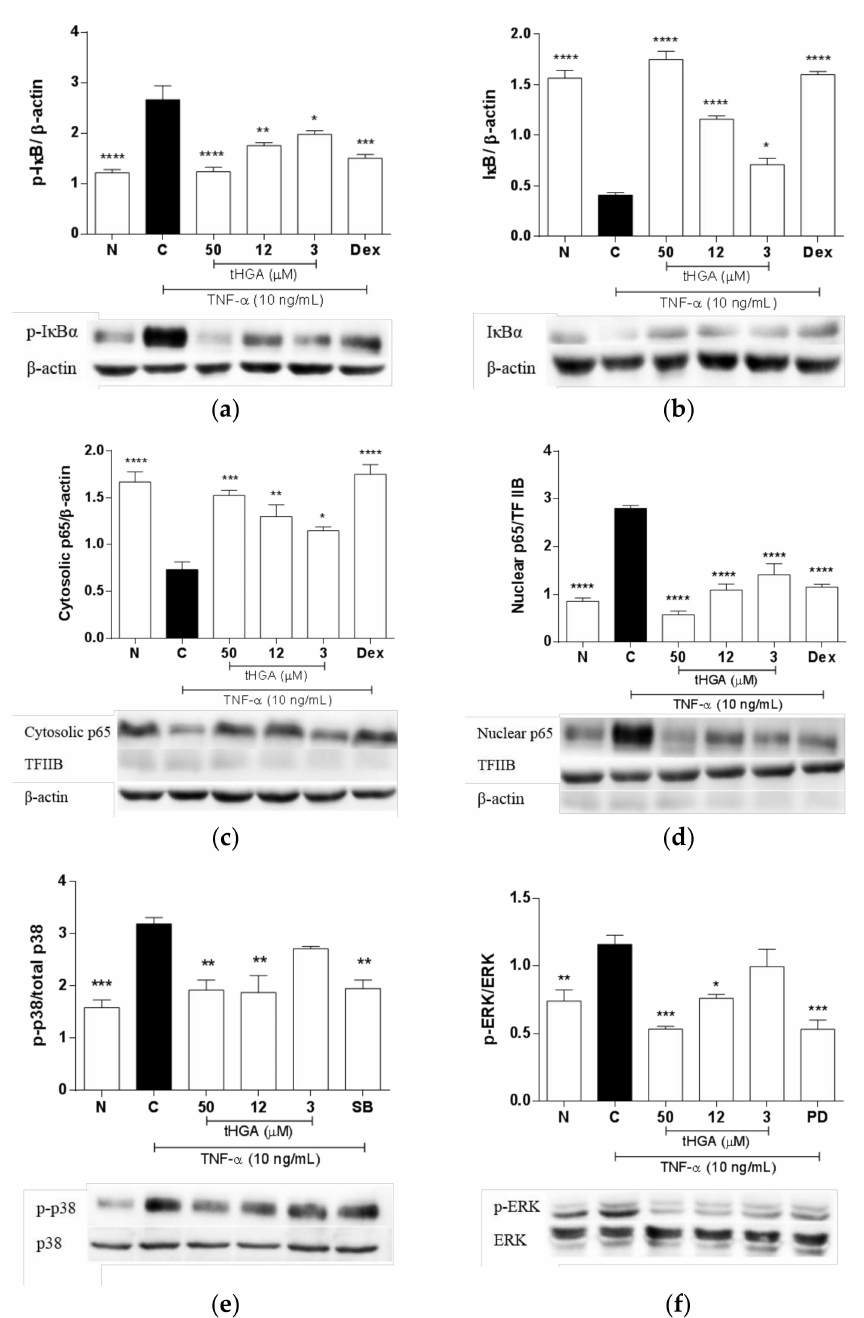
Figure 6. The effects of tHGA on the NF κ B and MAPK signaling pathways in A549 cells following TNF- α induction. ( a ) The levels of phosphorylated I κ B α , ( b ) total I κ B α , ( c ) cytosolic p65 and ( d ) nuclear p65 in A549 cells following TNF- α induction, in the presence of indicated treatments. ( e ) The levels of phosphorylated p38 and ( f ) phosphorylated ERK1/2 in A549 cells following TNF- α induction, in the presence of indicated treatments. A549 were induced with TNF- α (10 ng/mL), with indicated treatments for 60 min. Whole cell extracts were obtained and analyzed by Western blotting. Where necessary, cytosolic and nuclear fractions were obtained prior to Western Blot analysis, as described in Methods. Protein expression were normalized to either β -actin, TFIIB or respective total protein as indicated. Results shown are a representative blot from three independent experiments. All values are expressed as mean ± SEM of three independent experiments performed. * p ≤ 0.05, ** p ≤ 0.01, *** p ≤ 0.001 and **** p ≤ 0.0001 versus TNF- α -induced cells, according